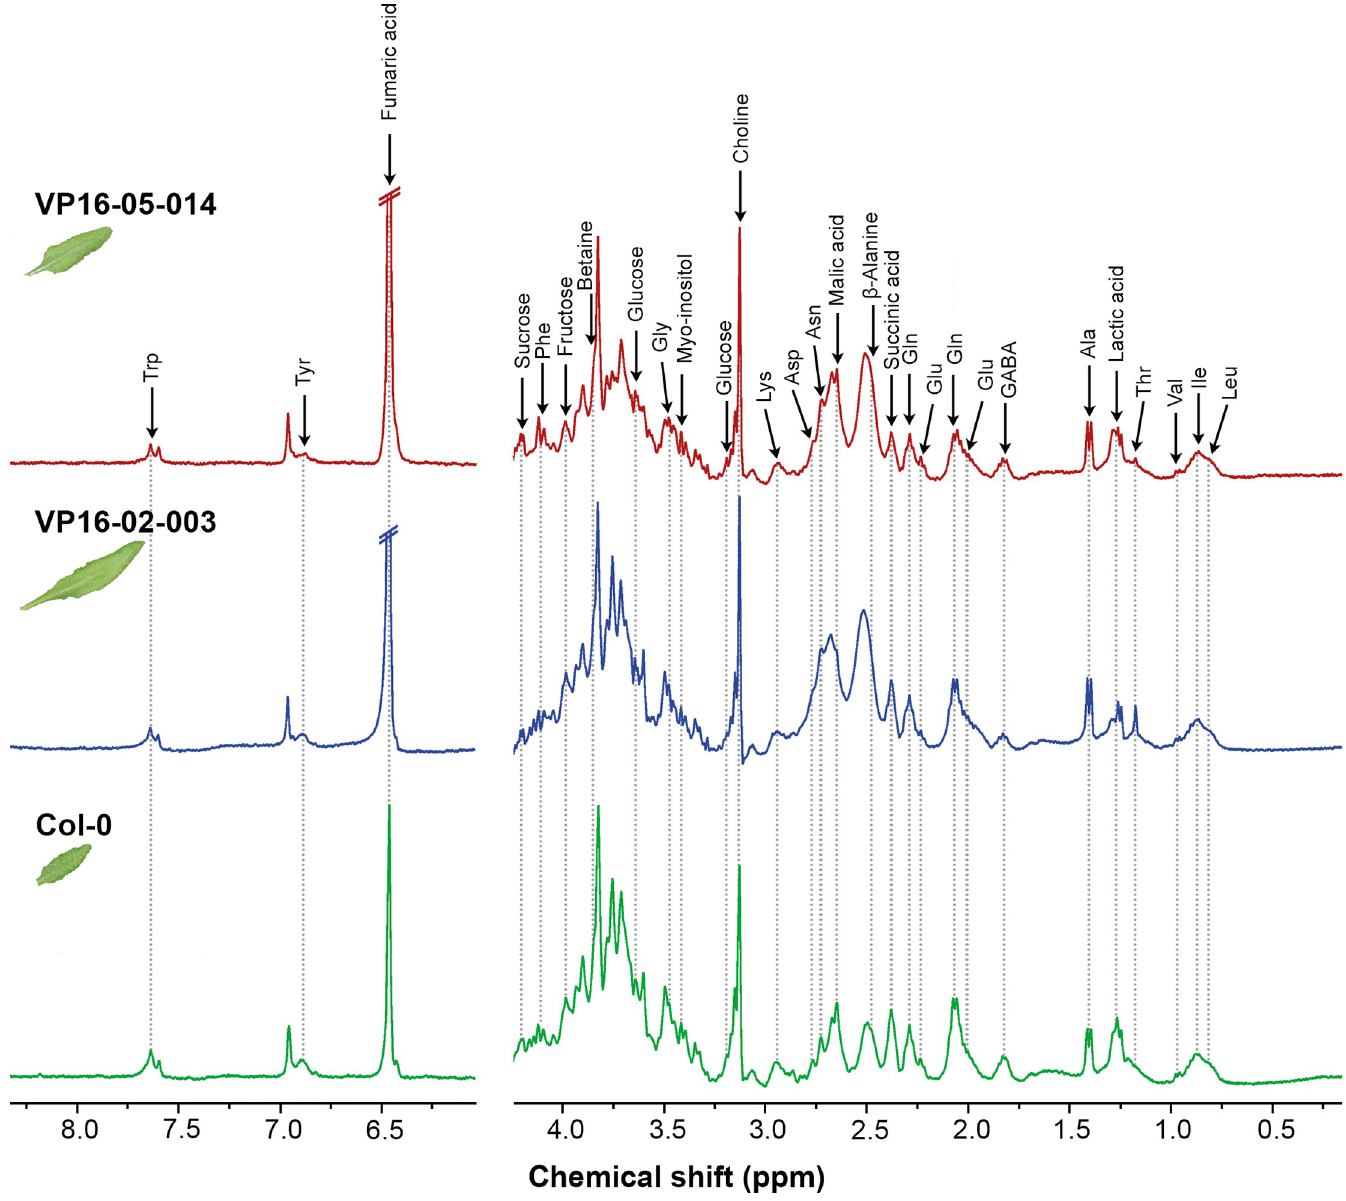
Fig 2. Representative one-dimensional 1 H HR-MAS NMR spectra collected from intact leaves of Arabidopsis thaliana Col-0 (bottom panels), VP16-02-003 (middle panels) and VP16-05-014 (top panels) grown in a 12h-light/12h-dark regime. The intact leaves were harvested 28 dpg at t = 6 hours (6 hours after the beginning of the light period) for the measurement. The signals from the assigned metabolites have been shown in the spectra (see S2 Table for